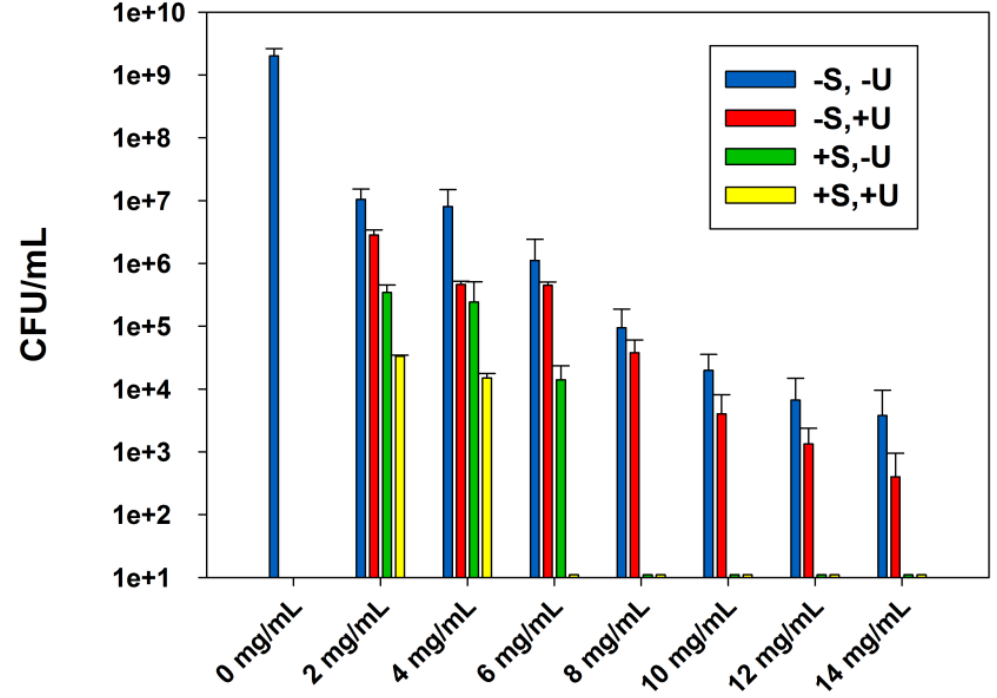
Figure 1. The effect of sterilization and ultrasound stimulations on the ABA of ZnO-NPs, in LB suspensions against E. coli (DH5α), after incubation at 37 °C for 24 h. Data are shown with mean values and standard errors of bacterial counts.